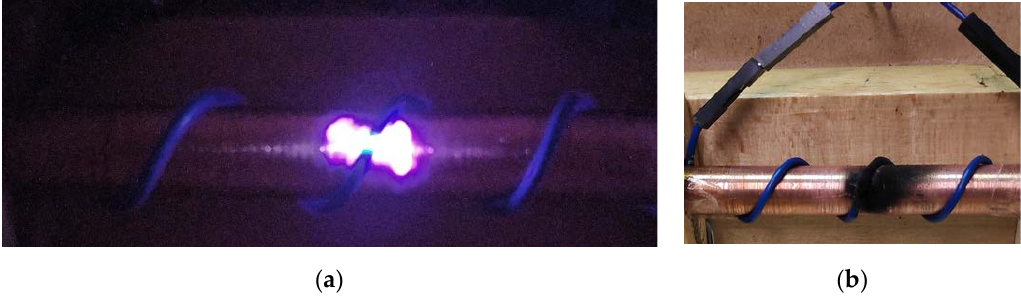
Figure 1. ( a ) Initial corona discharge at 10 kPa under 600 V–50 Hz. ( b ) Effect of arc tracking in a conductor.